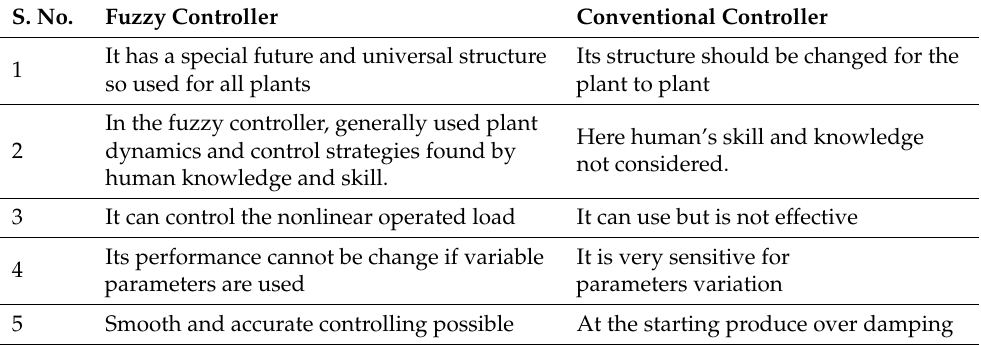
Table 1. Comparison between classical and fuzzy